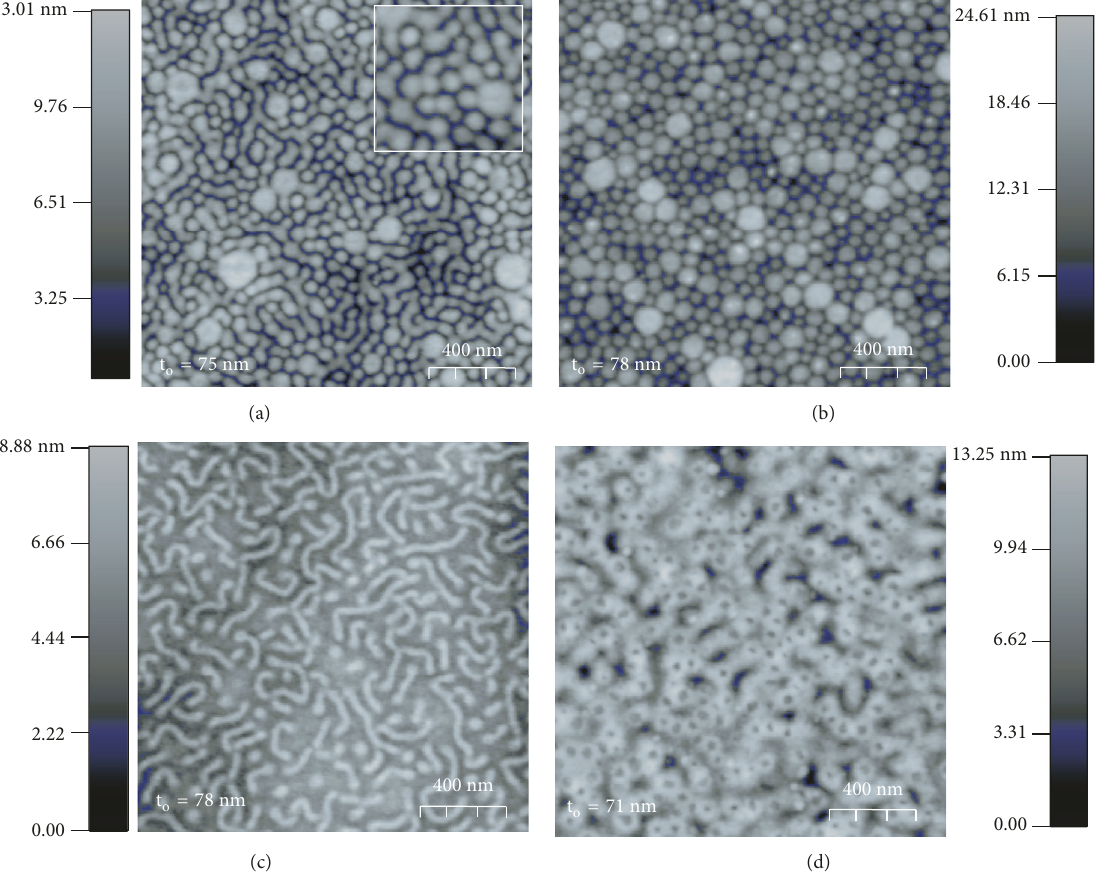
Figure 5: AFM height images of a highly sulfonated BC (M2 52/s48) subjected to different annealing treatments. (a) Thermally annealed (TA) at 170 ∘ C for 24 h. (b) SVA treated with THF (3 h), (c) SVA treated in a mixture of toluene/dioxane (50/50 v/v % for 3h). (d) SVA treated with dioxane for 3